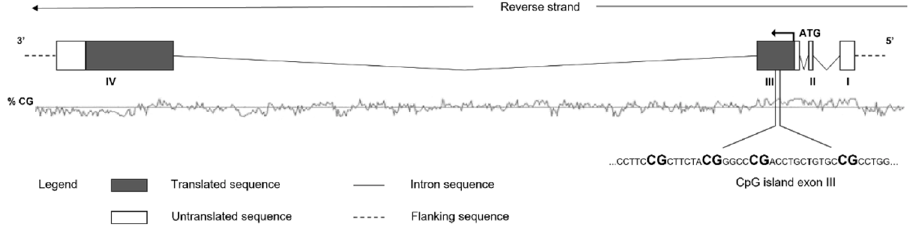
Figure 2. Schematic representation of human OXTR gene. Transcription start site position, exons, and introns are depicted, as well as region sequenced to analyze DNA methylation levels of the 4 CpG sites (in bold).